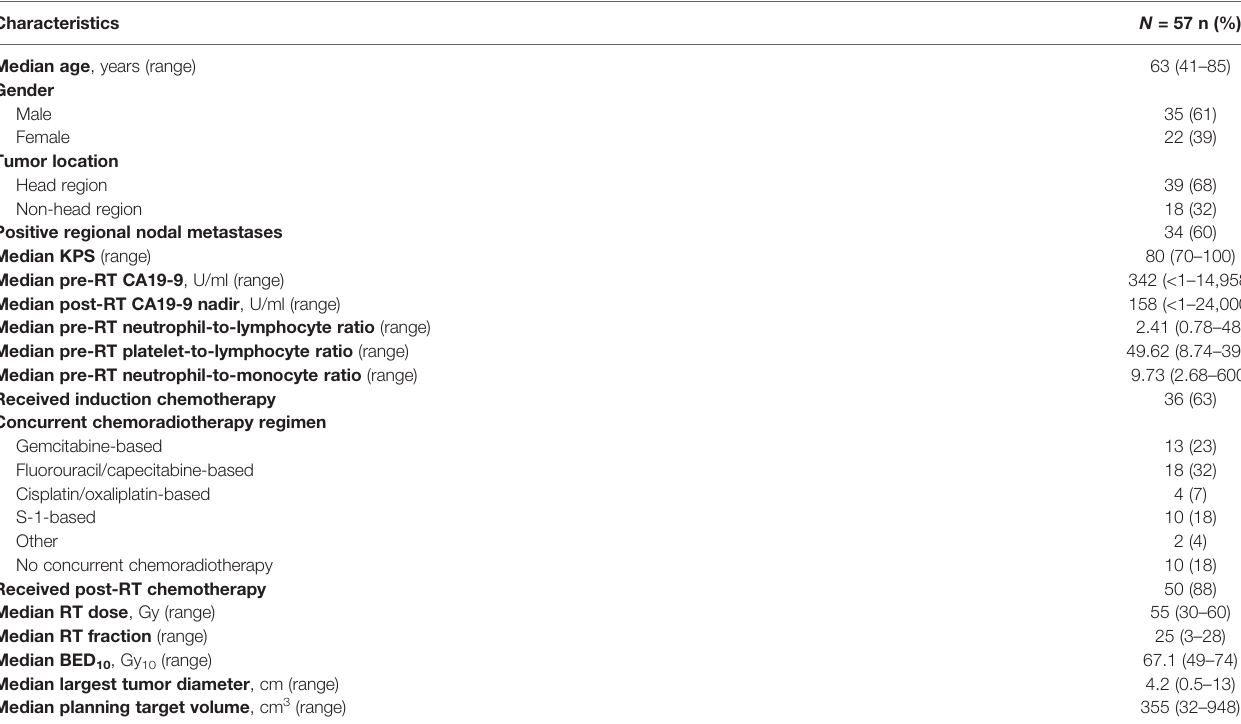
TABLE 1 | Clinical characteristics of patients and pancreatic tumor. Characteristics